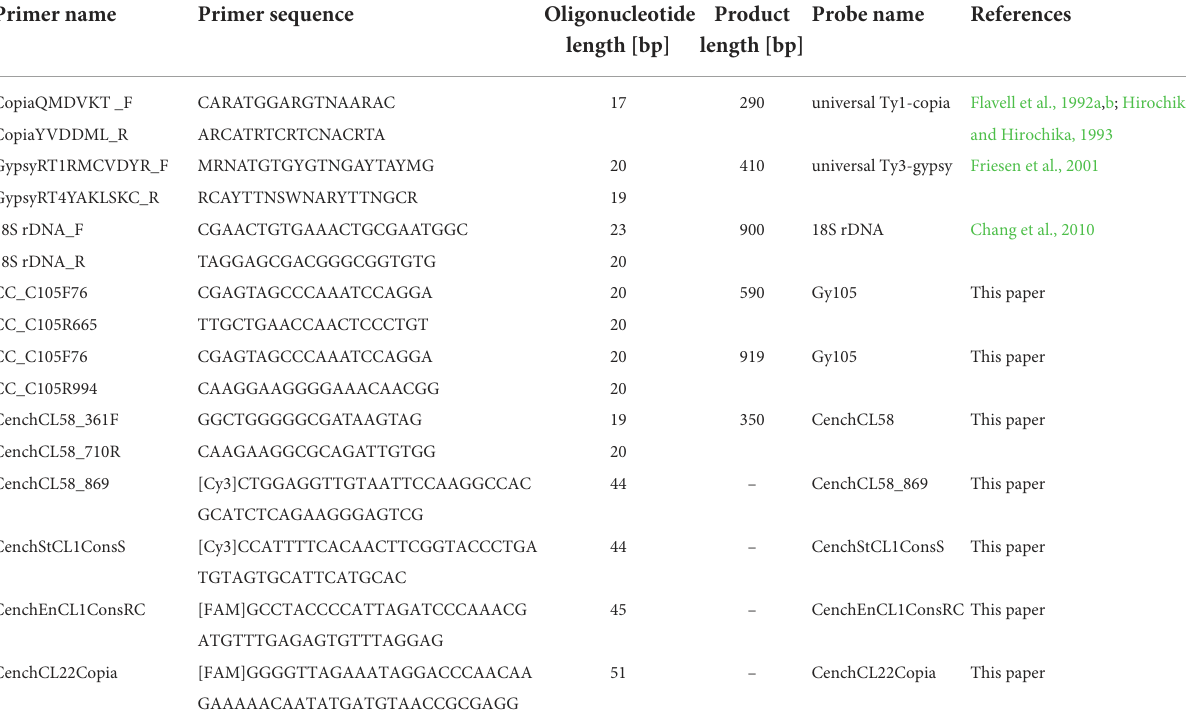
TABLE 1 List of PCR primers and commercial oligonucleotide probes used in the